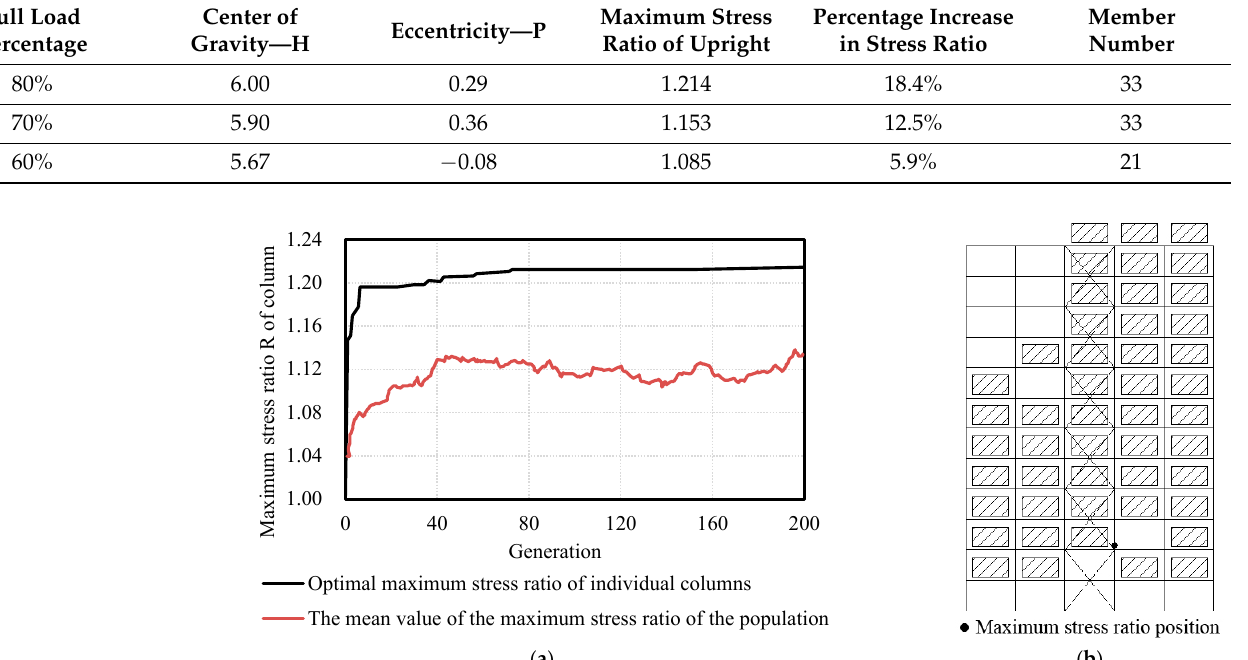
( a ) ( b ) Figure 7. The most unfavorable distribution of load under 70% full load. ( a ) Tracking chart of opti- mization performance of GA. ( b ) The most unfavorable distribution of load (H = 5.90, P = 0.36).